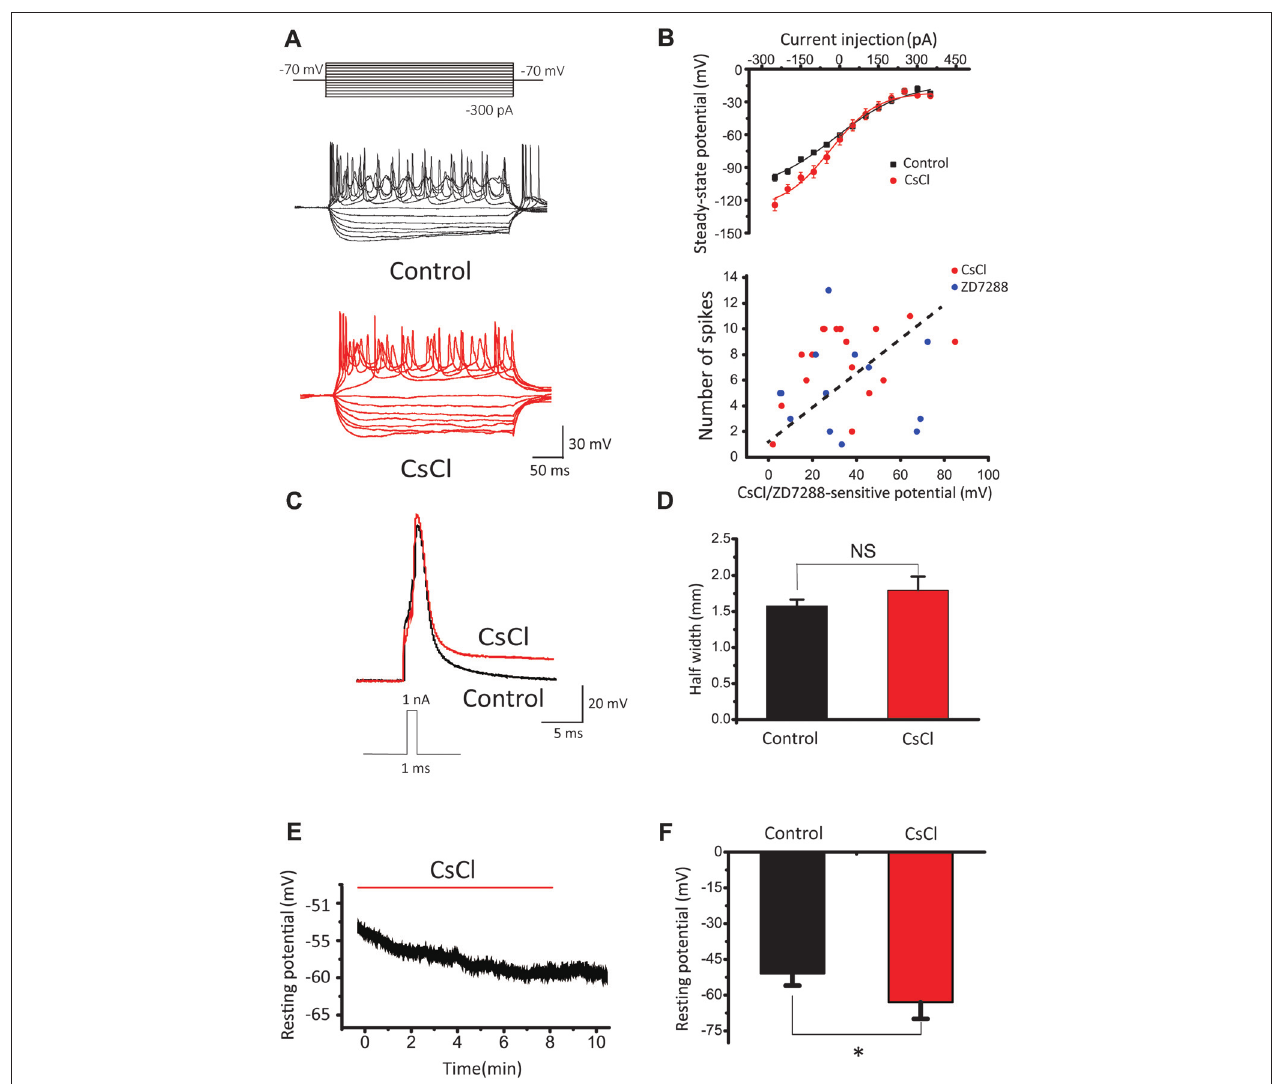
FIGURE 8 | The effects of HCN blockers in membrane properties. (A) Representative recordings in response to current step injections in control and CsCl. (B) Upper Panel: summaries of steady-state potentials measured within the last 5 ms range of the evoked potentials in control and CsCl. Lower Panel: relationship between CsCl/ZD7288 sensitive component of membrane potential at − 140 mV and maximal spike number among the same population of cells. (C) Superimposed APs evoked by 1 nA, 1 ms current pulses in control (black) and CsCl (red). (D) Summary plots of the effect of CsCl on the half-width of evoked APs. (E) Example of changes in resting membrane potential following application of CsCl. (F) Summary plots of the effect of CsCl on